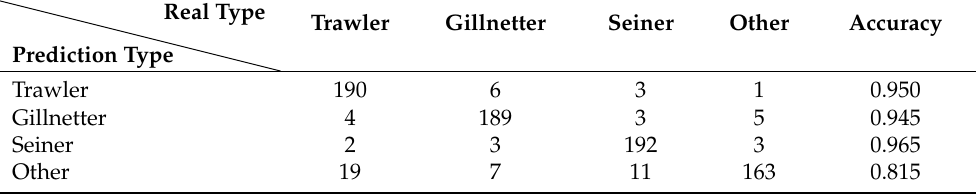
Table 7. Statistical results of the actual operation types of each fishing vessel in the classification results.